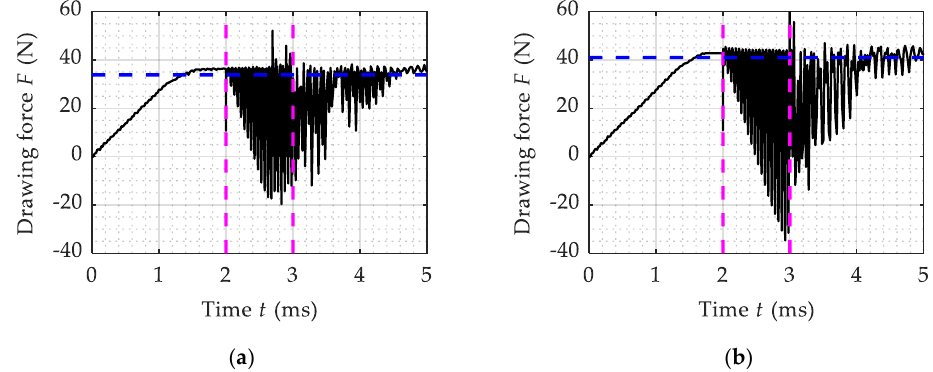
Figure 11. Time variation of drawing force with different friction coefficient when the distance between the reel and the die is 126.4 mm: ( a ) μ = 0.3; ( b ) μ = 0.5.